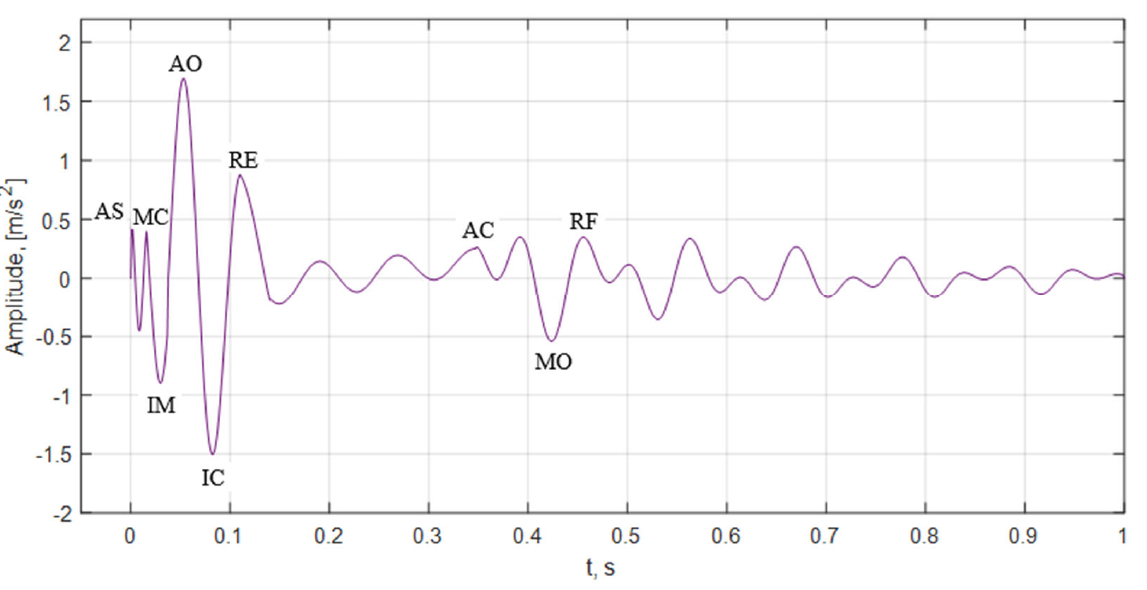
Figure 2. The mathematical model of the SCG signal. Where: AS—atrial systole; MC—closing of the